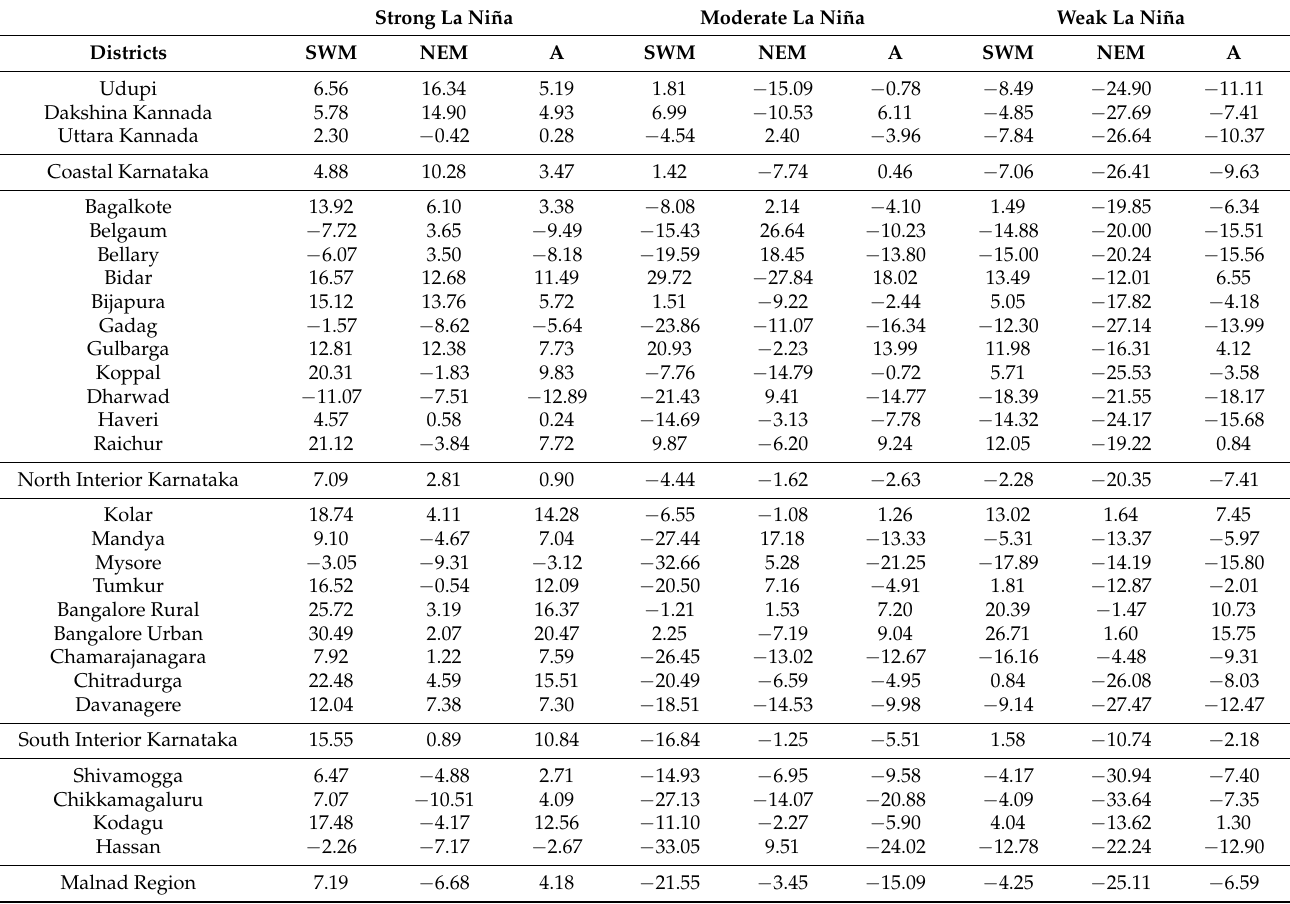
Table 4. District-wise percent change in seasonal and annual rainfall during La Niña years compared to normal years (1950–2018). Strong La Niña Moderate La Niña Weak La Niña Districts SWM NEM A Udupi